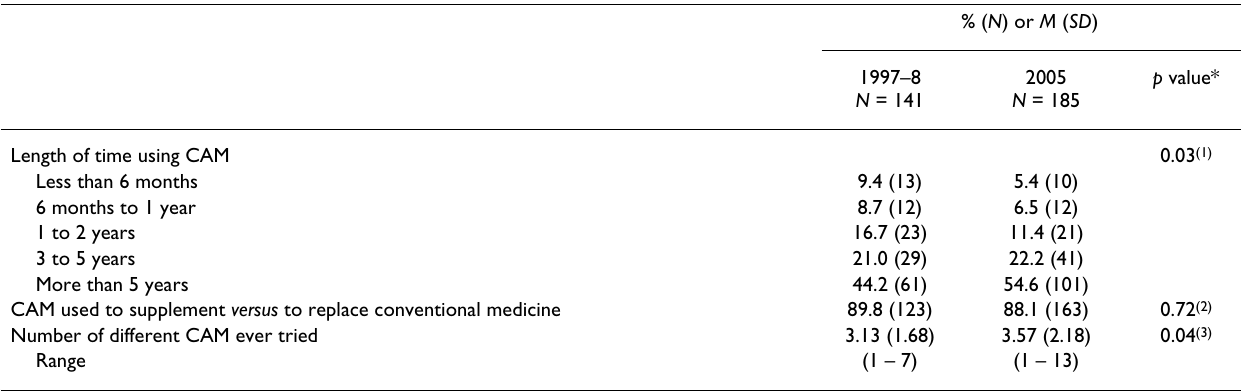
Table 2: CAM use: 1997–8 and 2005